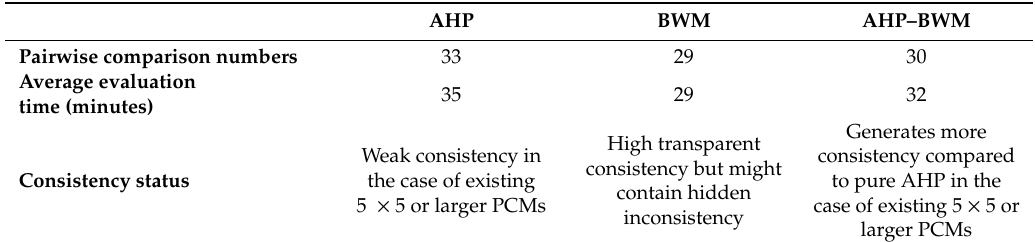
Table 13. The main di ff erences between the proposed model and the pure AHP and BWM approaches.